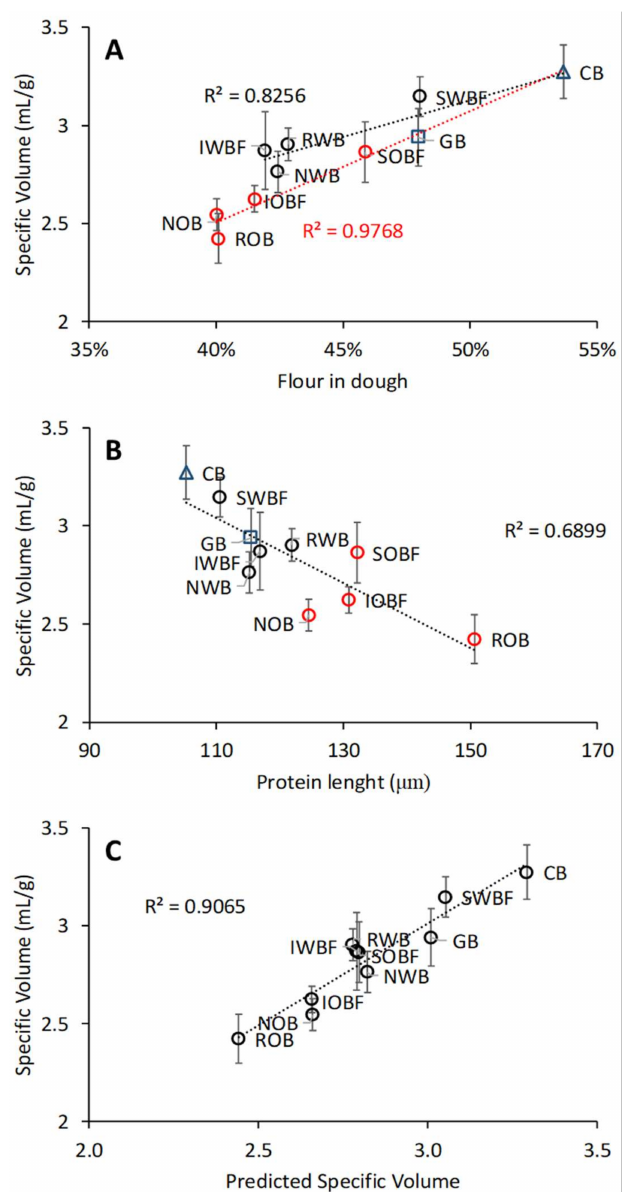
Figure 9. Association of specific volume with flour content in the dough ( A ) and with protein length as determined by analysis of CLSM images ( B ). Correlation between measured specific volume and the one predicted from flour content and protein length ( C ). In figures ( A , B ), black circles indicate wheat brans, and red circles indicate oat brans. Sample abbreviations are reported in Table